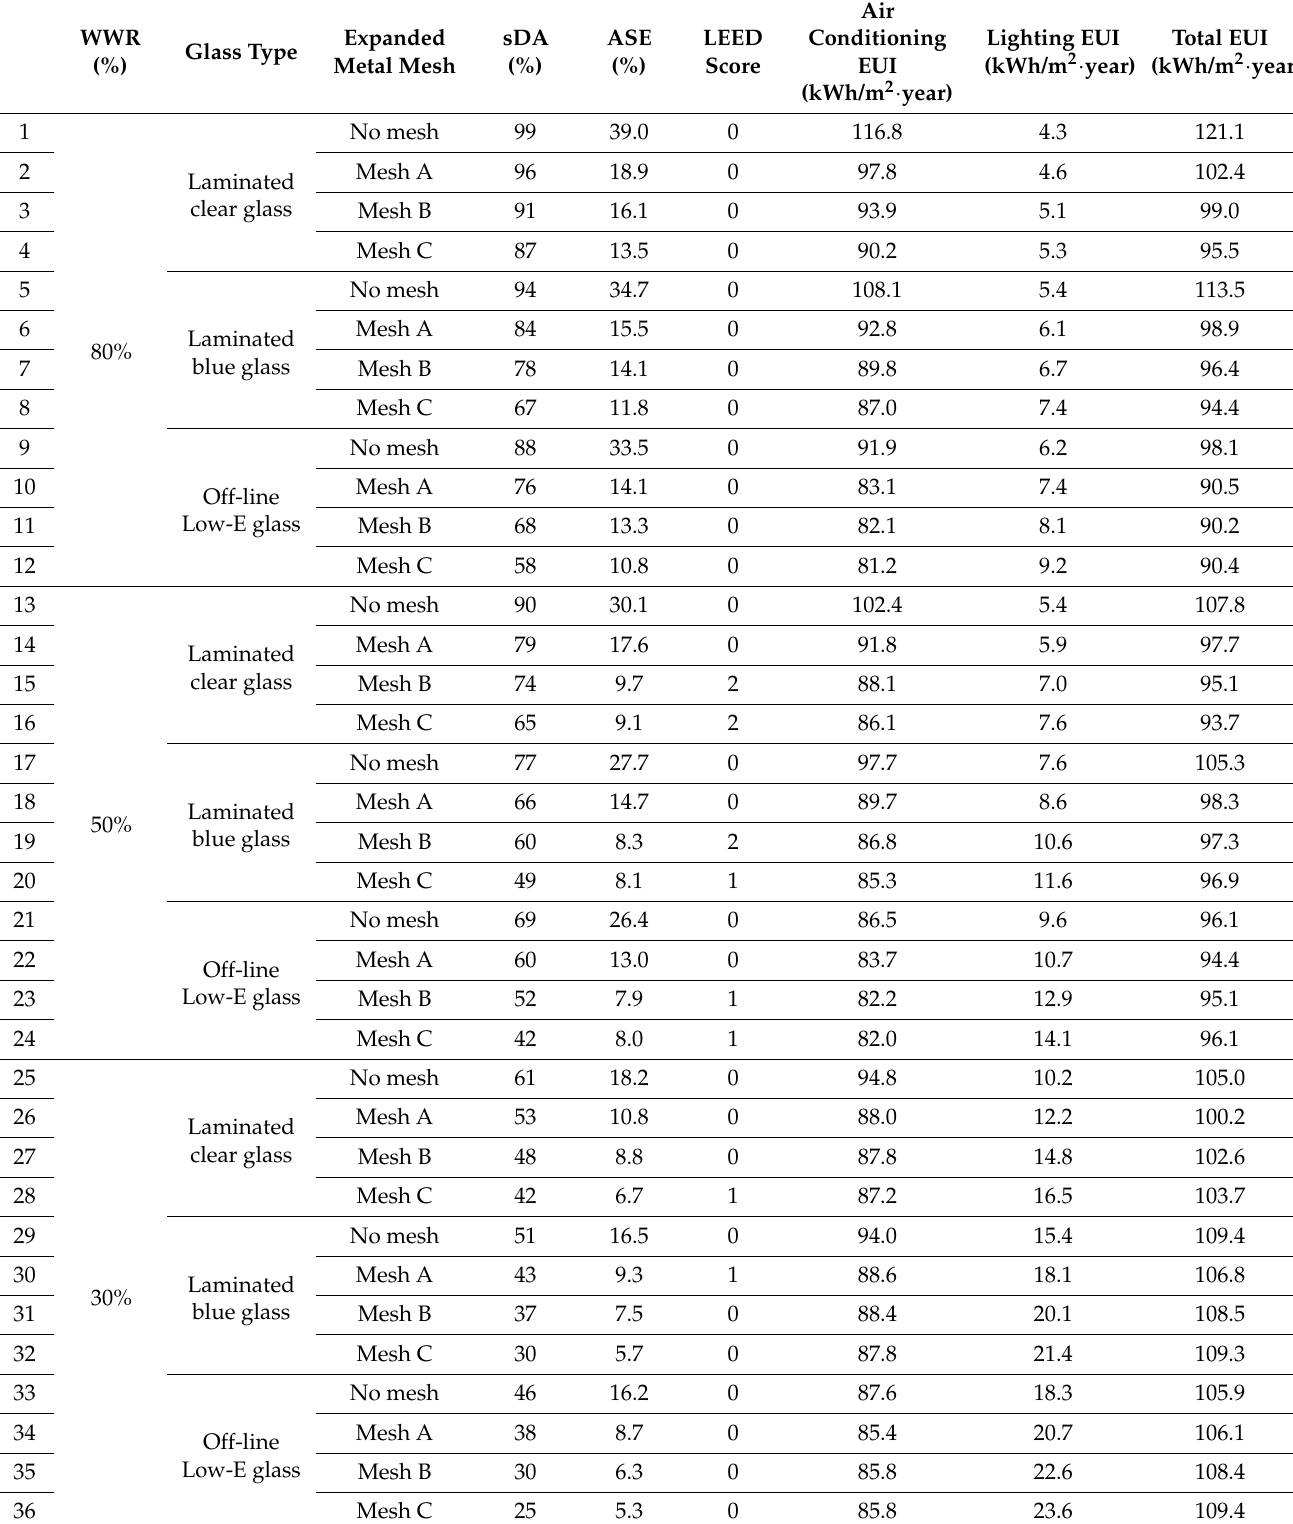
Table 10. Lighting and energy consumption result table of each simulated